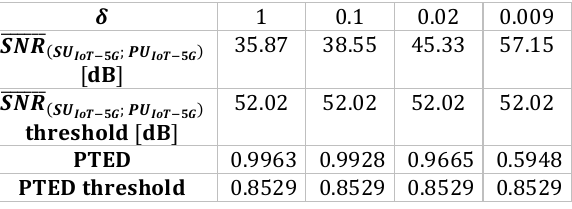
Table 4 . Improved PTDE at t = 139 s, in third scenario.